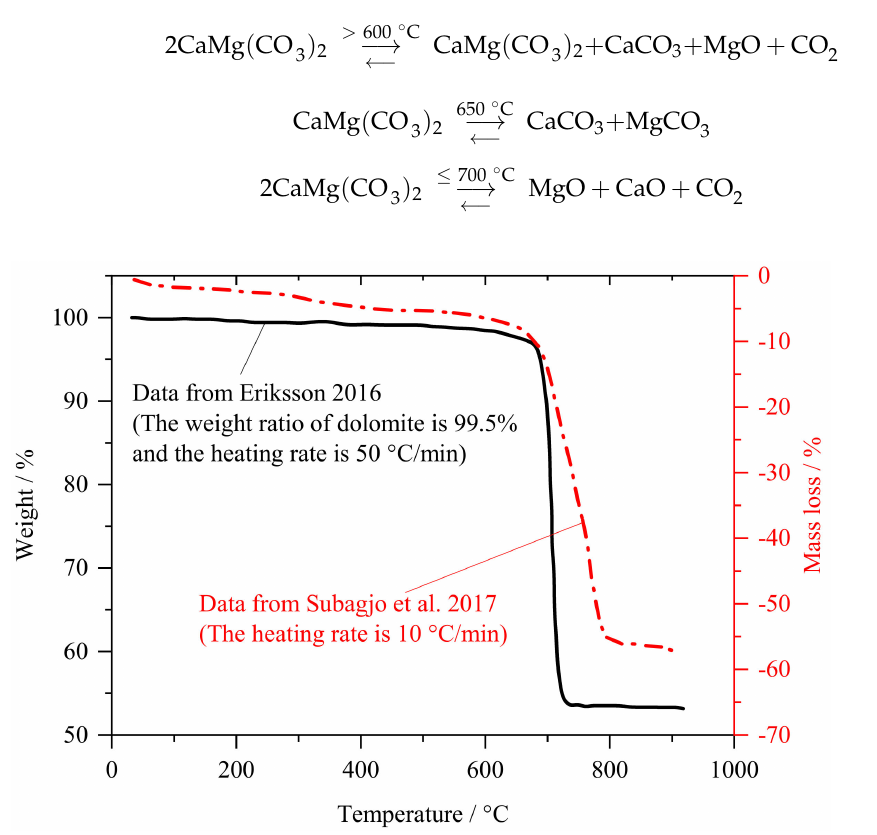
Figure 10. The thermogravimetry curves of